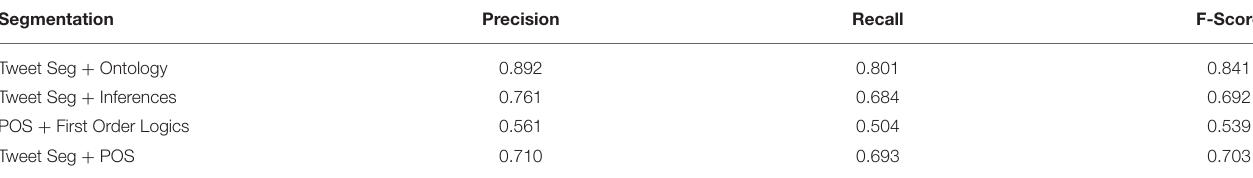
TABLE 3 | Tweet segmentation and classification for ontology matching.